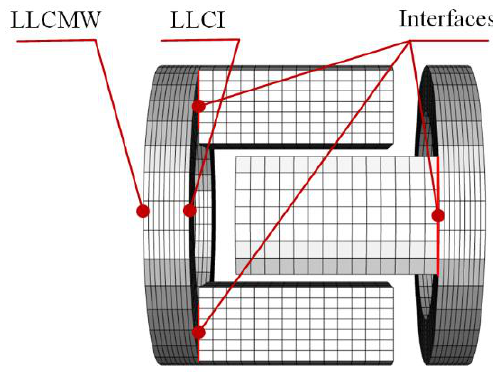
Figure 5. Boundary settings of the left pump unit.